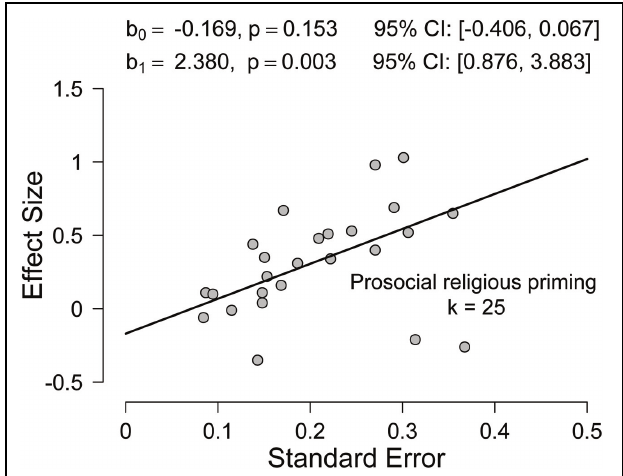
FIGURE 2 | Fit of the PET model to the subset of the religious priming studies explicitly focusing on the priming of prosocial behavior ( k = 25) in the meta-analysis by Shariff et al.